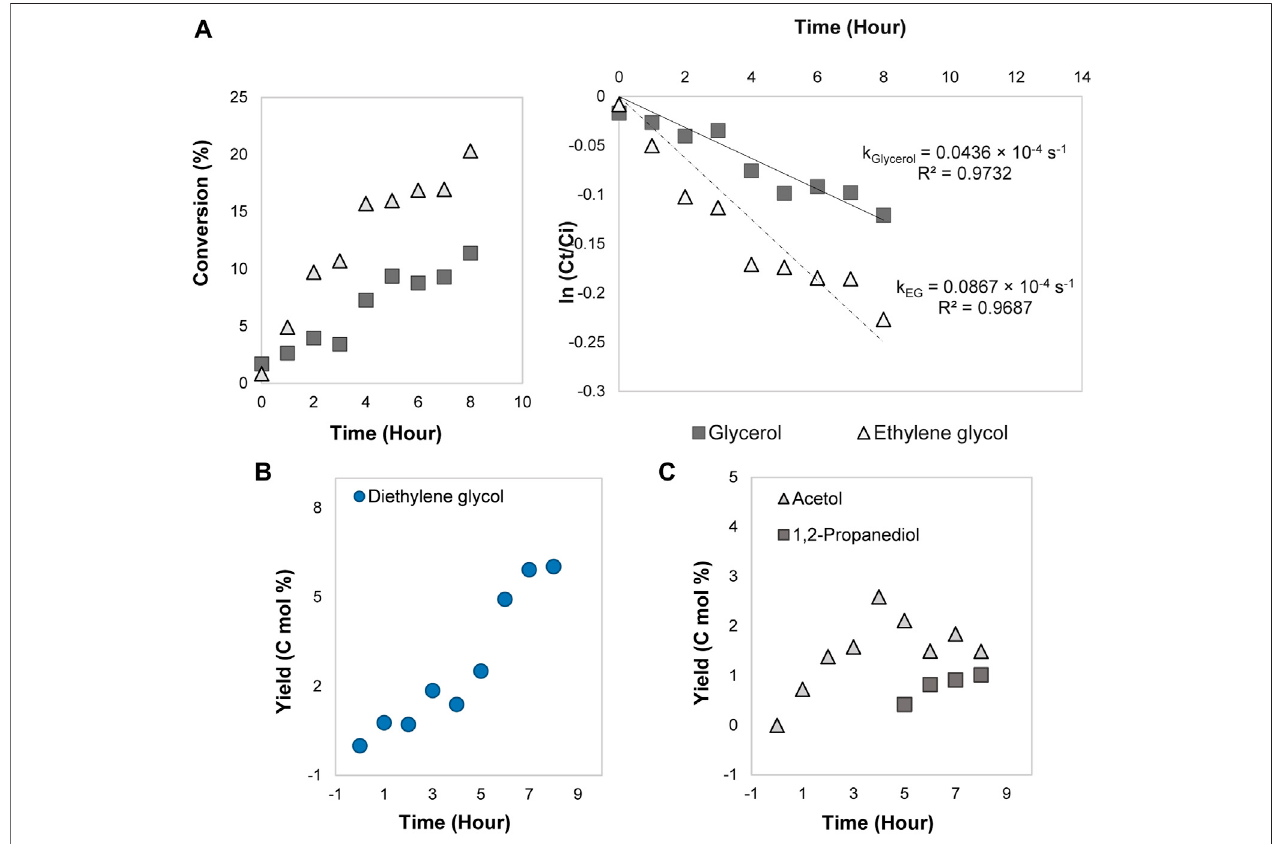
FIGURE 3 | (A) Conversions and fi rst-order kinetics models for ethylene glycol and glycerol reactions. Products distributions from (B) ethylene glycol and (C) glycerol dehydration.